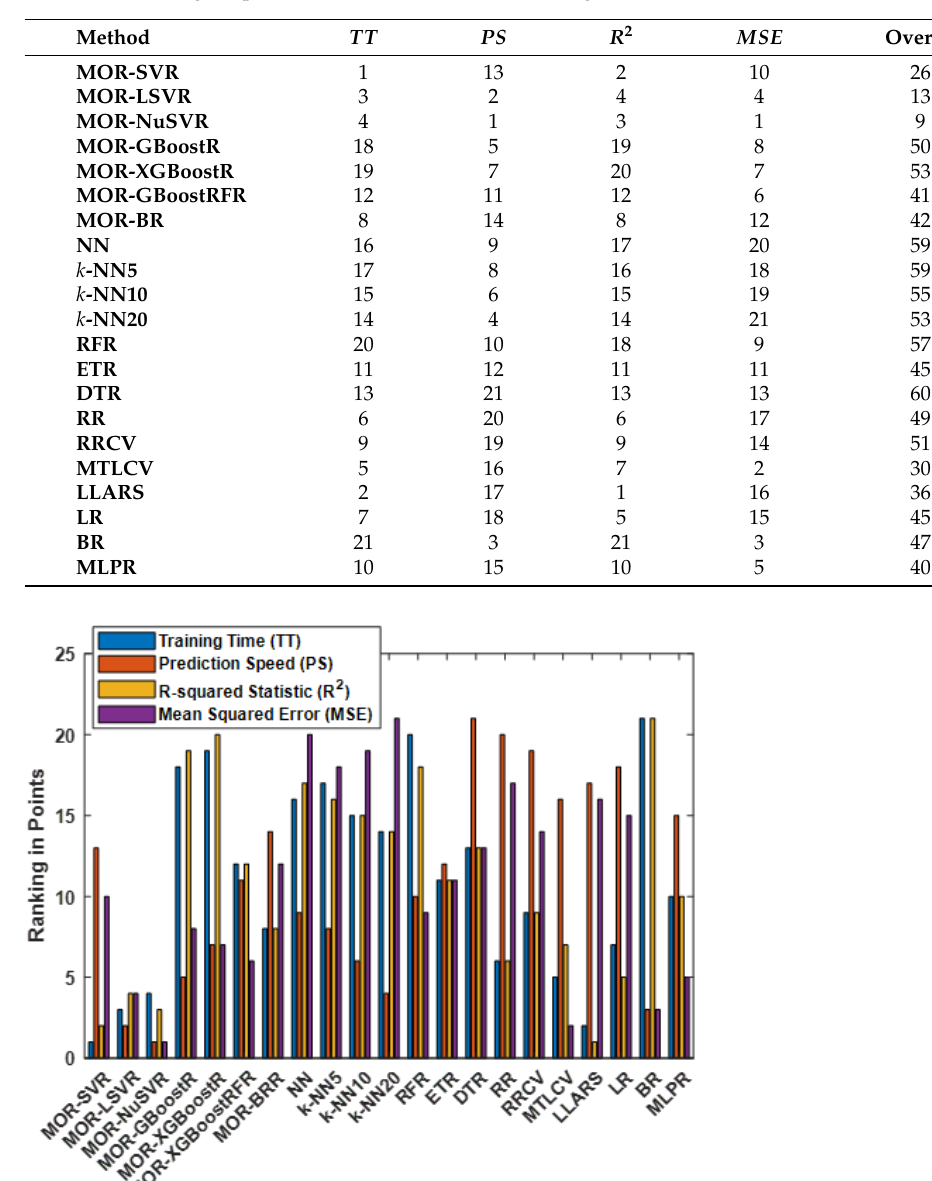
Table 12. Ranking (in points) of all methods (the first stage).